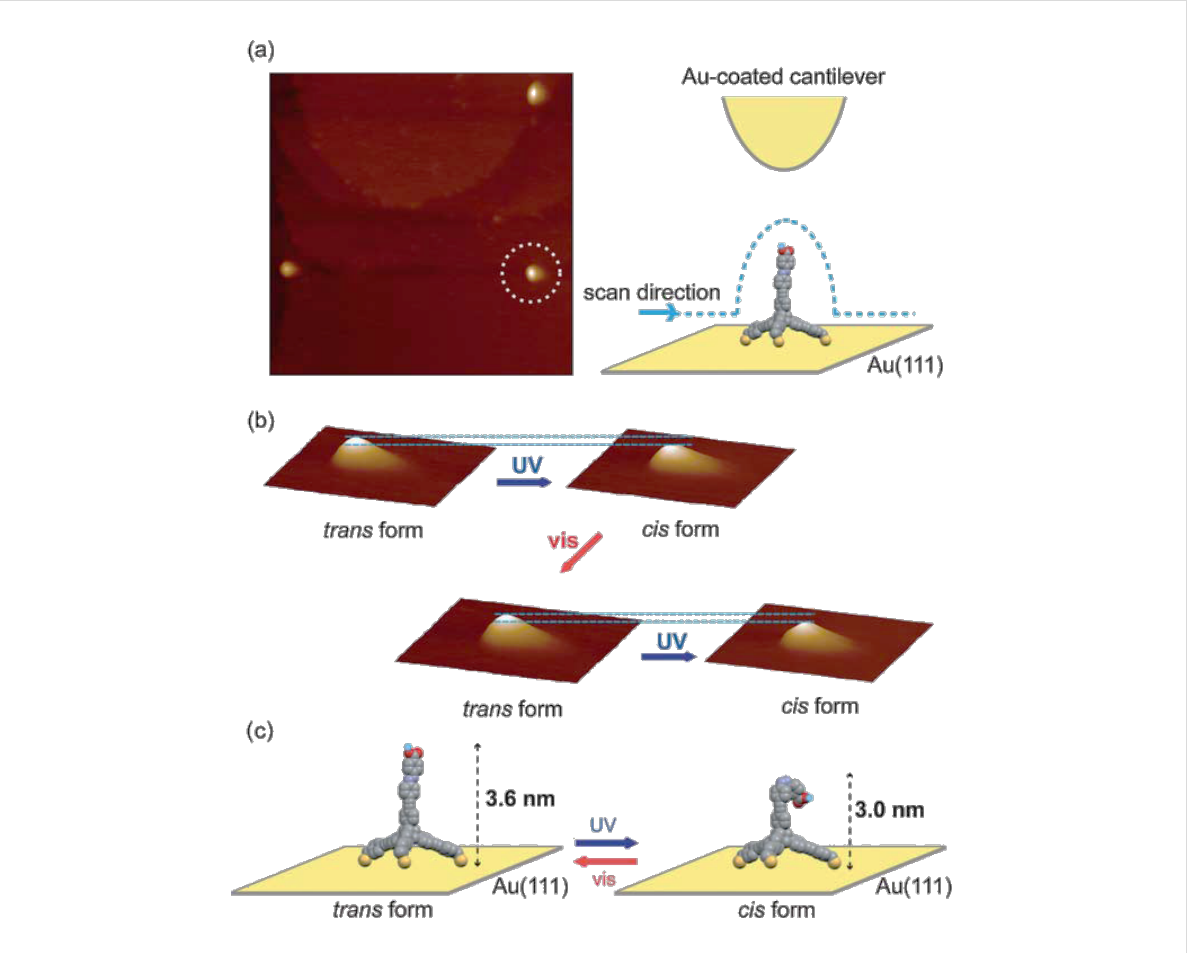
Figure 6: (a) UHV-NC-AFM image (350 × 350 nm 2 , Δ f = − 28 Hz) of 4-carboxyazobenzene 13 adsorbed on Au(111) using a Au-coated cantilever and schematic of the measurement. (b) A series of 3D view of NC-AFM images (55 × 55 nm 2 , Δ f = − 28 Hz) of 13 adsorbed on Au(111), which was indicat- ed by a white circle in (a) representing the trans form (after visible light (450 ± 10 nm) irradiation) and the cis form (after UV light (360 ± 10 nm) irradia- tion) and corresponding line profiles are indicated. (c) Molecular models of 13 fixed on the Au substrate in trans and cis configurations. Reproduced with permission from [90], copyright 2010 The Royal Society of